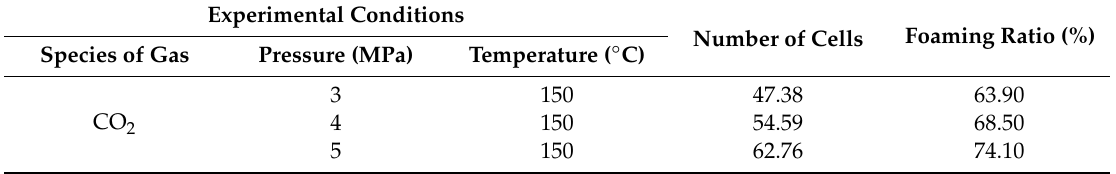
Table 7. Foaming properties of thermoplastic polyurethanes (TPU) according to saturation pressure.